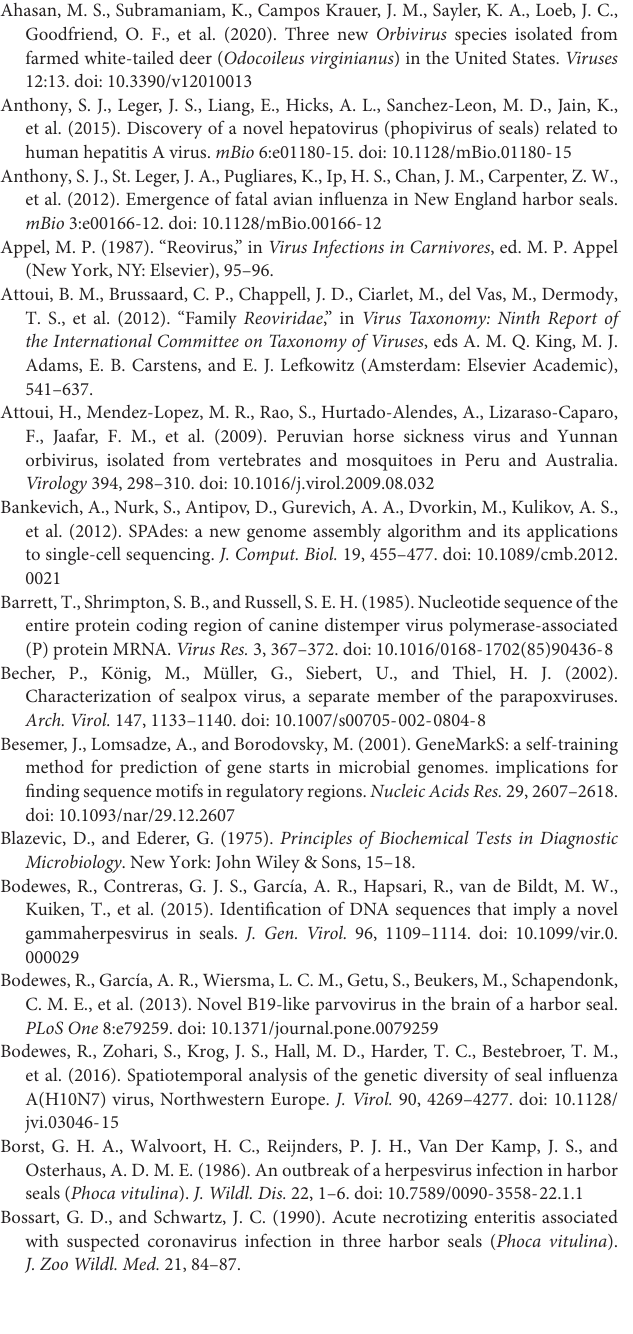
identity matrix showing the aa percent identity of the novel harbor seal virus to 27 other orthoreoviruses based on the sigma NS protein (segment S3). Virus name are listed, followed by isolate/strain identification when available. Virus abbreviations: MRV1, mammalian orthoreovirus 1; MRV2, mammalian orthoreovirus 2; MRV3, mammalian orthoreovirus 3. Supplementary Table 1 | Orthoreoviruses used in the phylogenetic and genetic